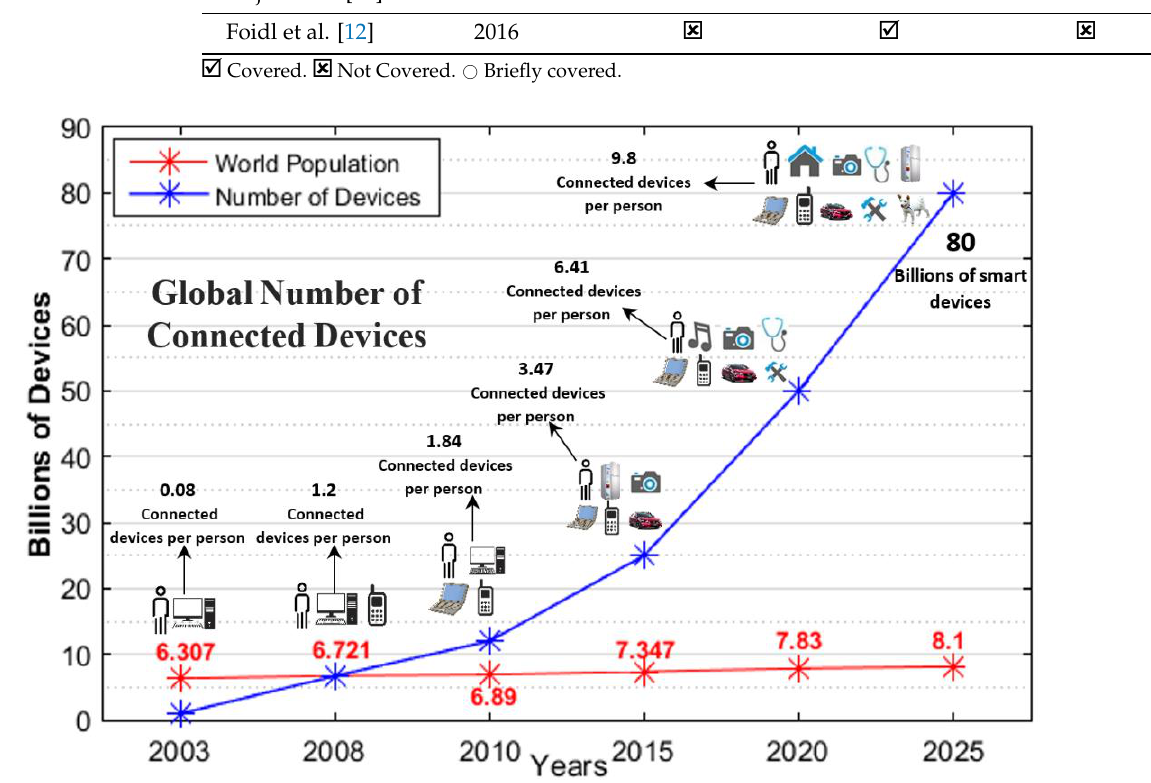
Table 1. Cont . Table 1. Summary and comparison of our survey and current recent research. Table 1. Summary and comparison of our survey and current recent research. Table 1. Summary and comparison of our survey and current recent research.